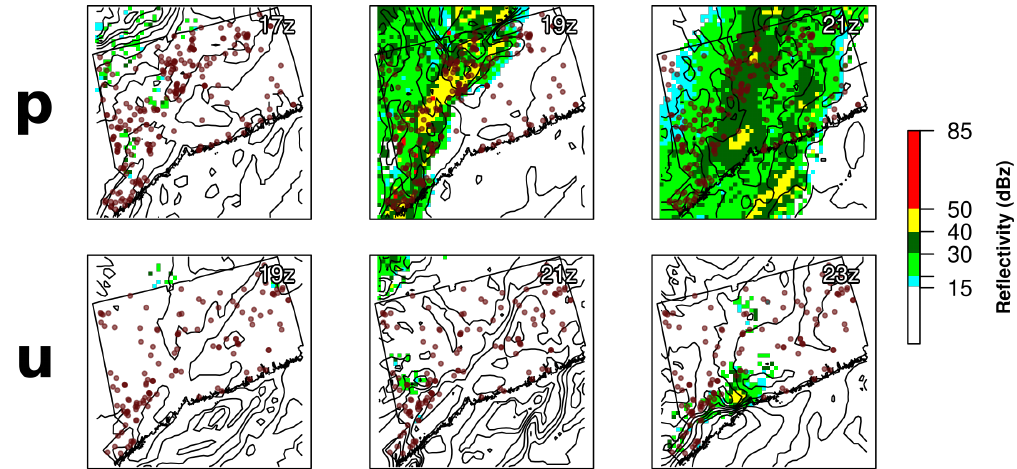
Figure 5. HRRR-simulated zero-hour reflectivity and contours of wind speed at three hours, overlaid with outage occurrences accumulated over the 18-h period of a well-predicted storm (“p”; average hourly r 2 = 0.779) on 17 July 2018 ( top ), and a poorly predicted storm (“u”; average hourly r 2 = 0.074) on 8 August 2018 ( bottom ). The center plot for each storm illustrates the hour of peak outages, with the left two hours before, and the right two hours